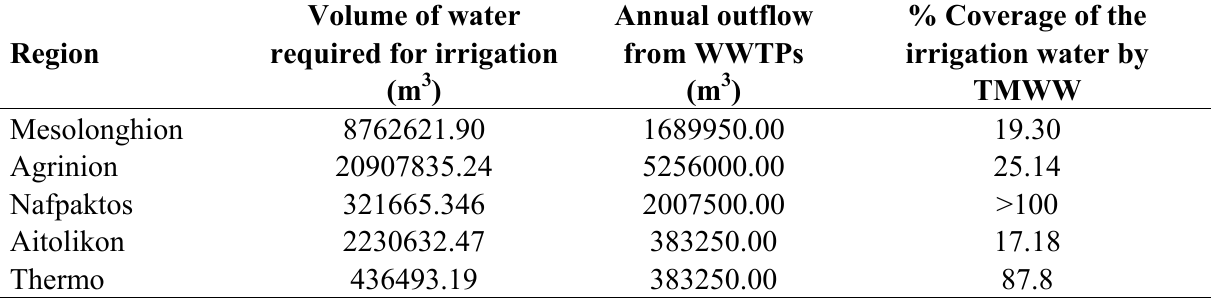
Table 4. Contribution of the WWTPs effluents to the annual irrigation water required by each of the areas